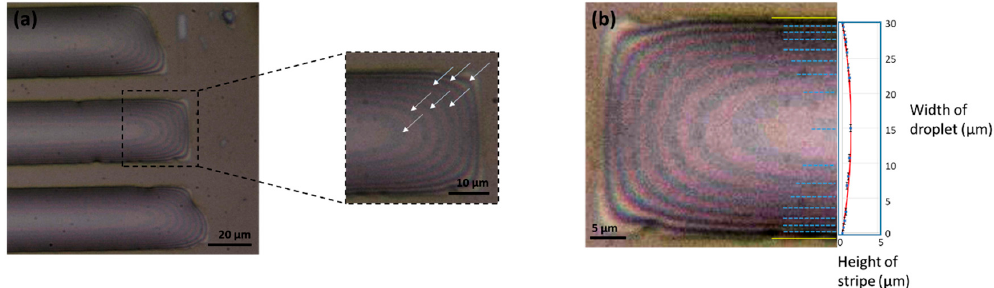
Figure 6. ( a ) Reflectance mode image of E7 cylindric-section droplet. Inset shows a magnified region of an LC stripe with arrows clearly indicating the observed interference fringes. ( b ) To scale. Calculated heights corresponding to each of the fringes (length of the solid blue lines) plotted against their positions and fitted to a section of a circle (solid red line). Dashed blue lines are intended as “guides” to the eye. The image has been contrast-enhanced to help show the interference fringes. Table 2. Radius, height and contact angle values for w = 30 μ m wide channels.